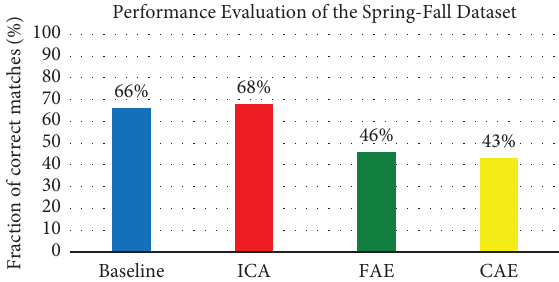
Figure 11: Fraction of correct matches of the baseline and pro- posed algorithms on the spring-fall